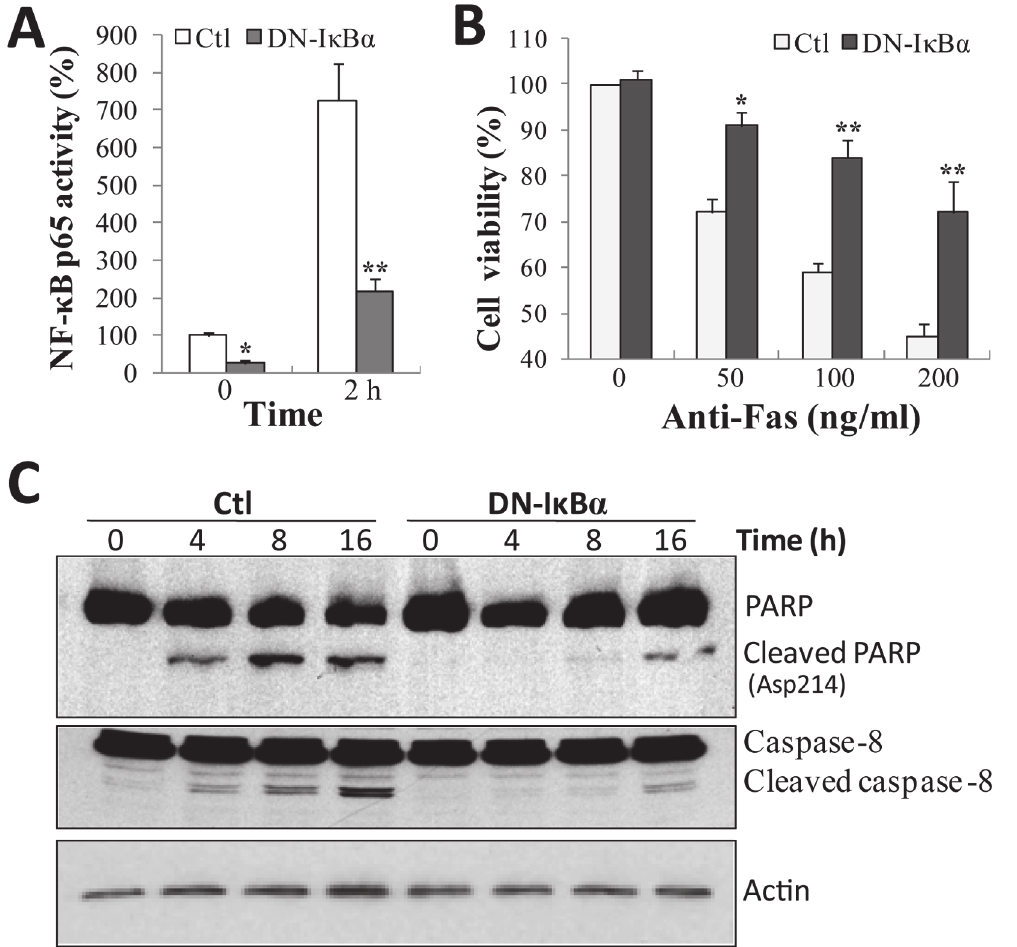
Fig 2. NF- κ B inhibition protects neuroblastoma cells from Fas-induced apoptosis. ( A ) SH-EP1 cells transfected with control vector (Ctl) or DN-I κ B α expression vector (DN-I κ B α ) were treated with anti-Fas antibody (100 ng/ml) for 2 h. NF- κ B activation was analyzed using NF- κ B p65 reporter assay. ( B ) Cells were treated with anti-Fas antibody of different concentrations for 1 d, and cell viability was examined using crystal violet staining. ( C ) Fas-treated cells were lyzed and Western blotting was performed with antibodies against cleaved PARP and caspase-8. Membranes were re-probed with β -actin as a loading control. Results are representative of at least three experiments. ** P < 0.01 and *** P < 0.001, compared with control SH-EP1